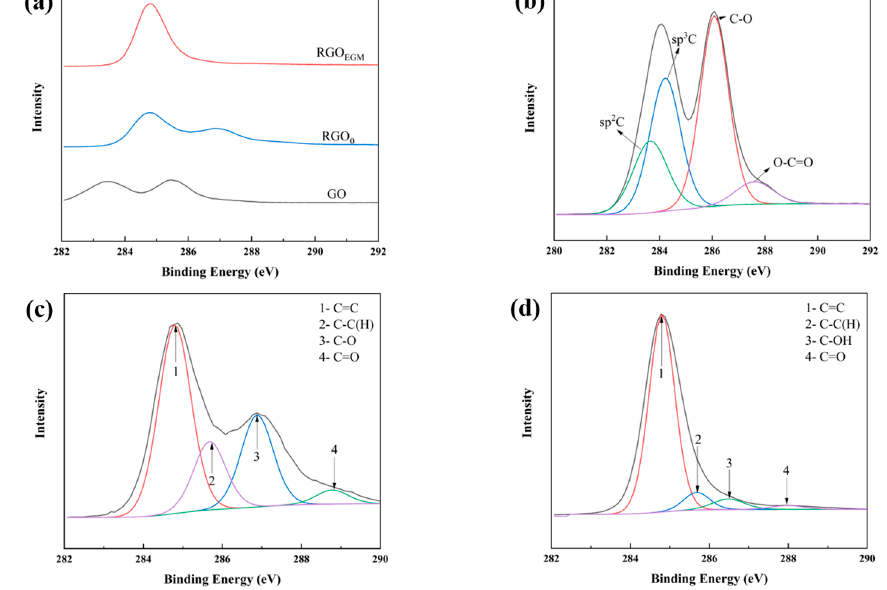
Figure 3. X-ray photoelectron C 1s region mapping of ( a ) GO, RGO 0 , and RGO EGM ; C 1s X-ray photoelectron spectrum of ( b ) GO, ( c ) RGO 0 , and ( d ) RGO EGM .